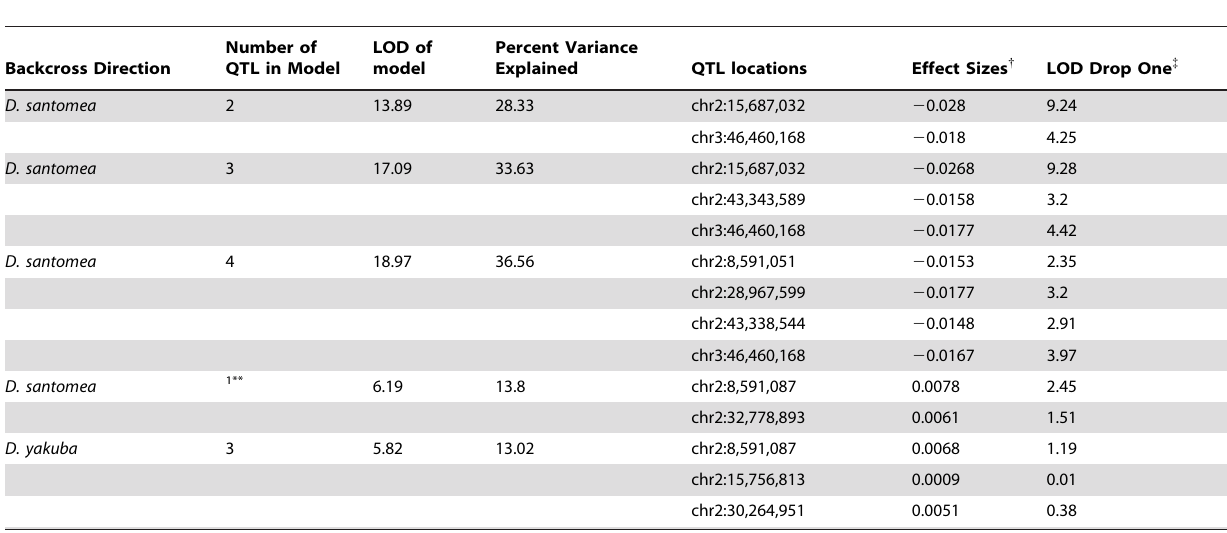
Table 1. Best fit QTL models for different numbers of QTL for the D. santomea and D. yakuba backcrosses.